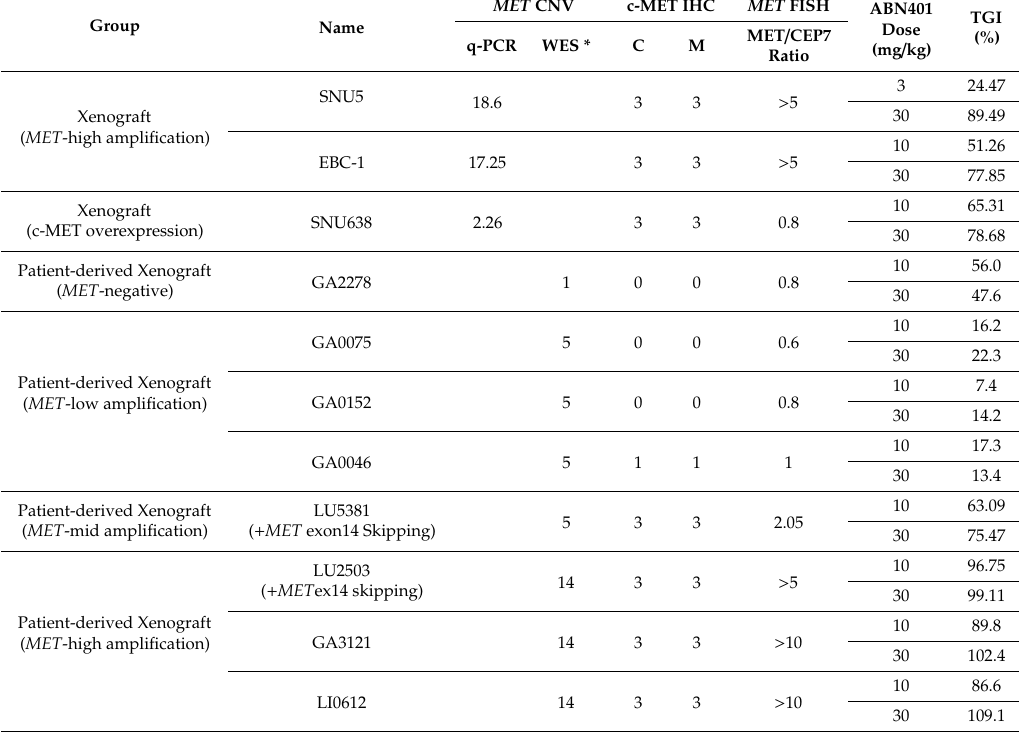
Table 2. The MET status and efficacy of ABN401 in cancer cell lines and patient-derived xenograft (PDX) models.